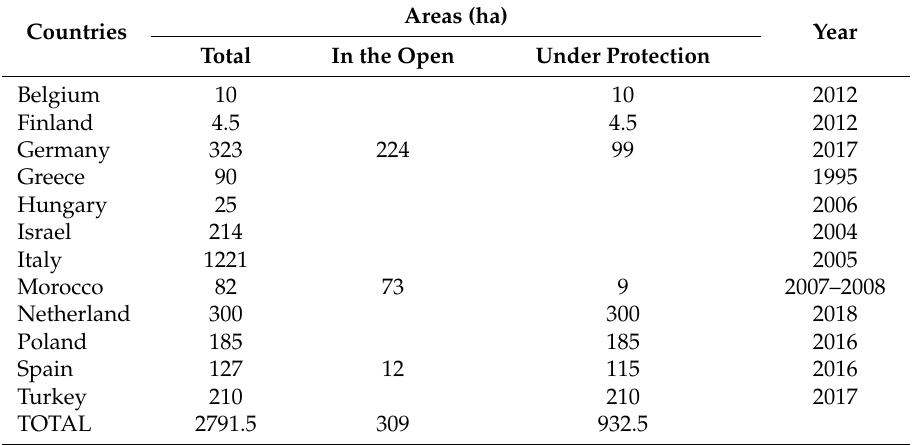
Table 1. Cultivated areas (ha) of cut roses in di ff erent Mediterranean and European countries 1 . Areas (ha) Countries Year Total In the Open Under Protection Belgium 10 10 2012 Finland 4.5 4.5 Germany